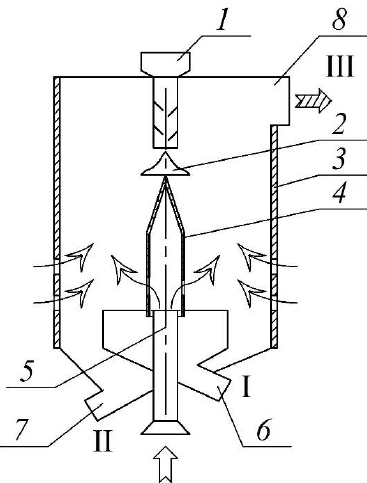
Figure 6. Structural and technological scheme of the pneumatic gravity classifier: 1—loading hopper; 2—distribution cone; 3—perforated cylindrical pneumatic channel; 4—conical insert; 5—air supply pipe; 6, 7—yield of seed fractions; I—output of the grain material fraction with the highest density (1350–1500 kg m −3 ); II—output of the fraction of grain material with an medium density (1200–1350 kg m −3 ); ІІІ—output of light fraction of grain material with density 500–1200 kg m −3. To calculate the trajectories of movement of grains in a pneumatic separating channel of a cross section that is variable in height, the distribution of air velocity in height is determined by the next equations.